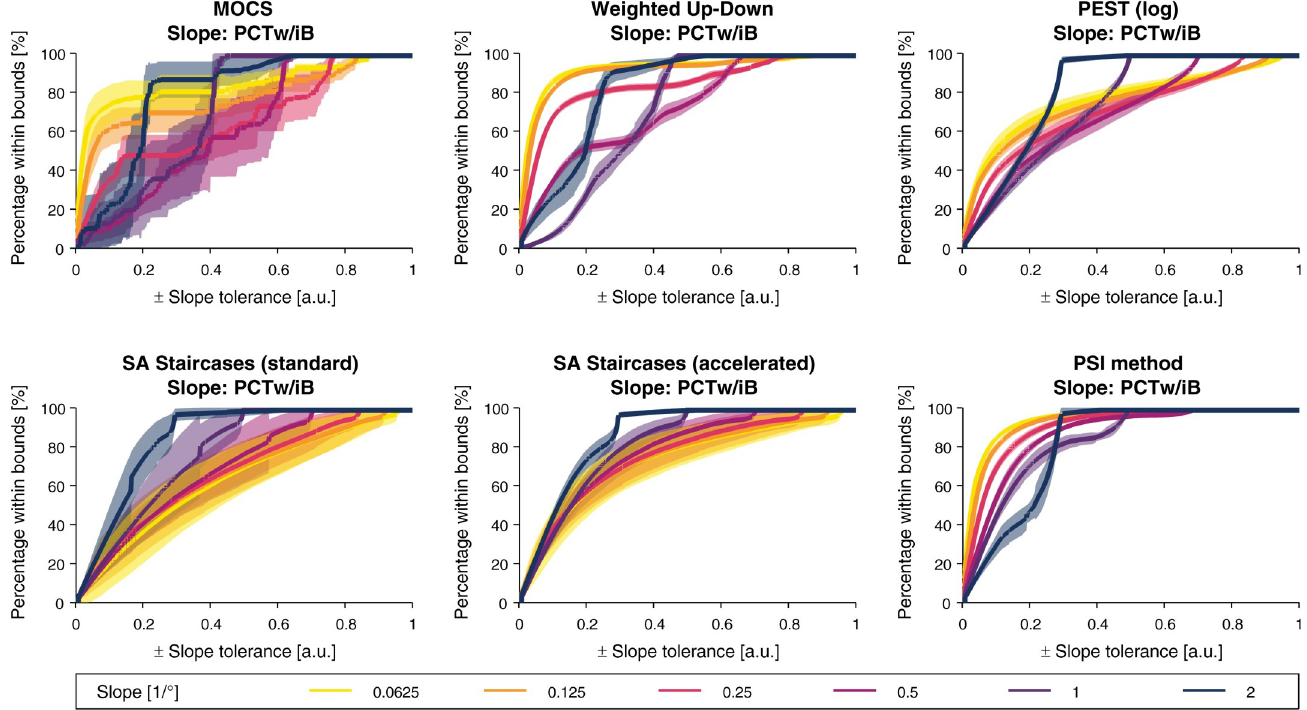
Fig 11. Percentage within bounds for the slope estimates. For each slope value of the template parameter set, the percentage within bounds ( PCTw/iB ) function for slope estimation are shown with the mean (bold line) and standard deviation (shaded band) across all modeled thresholds.